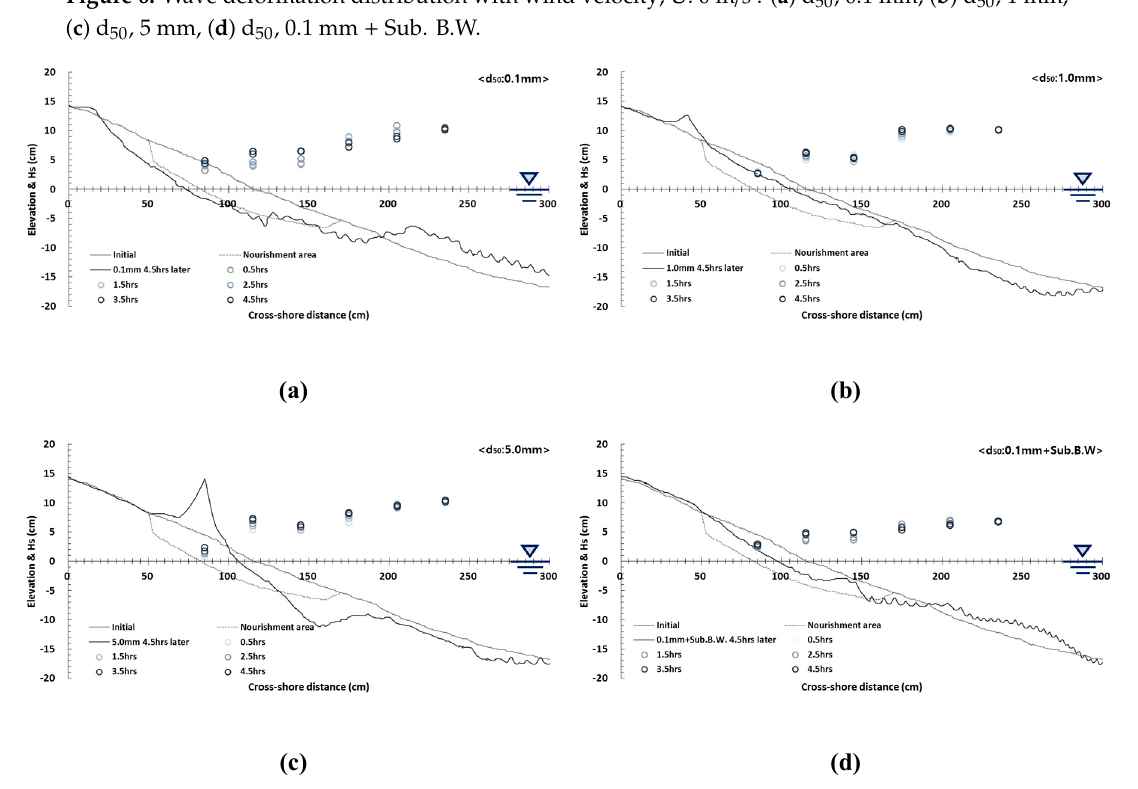
Figure 7. Wave deformation distribution with wind velocity; U: 8 m/s : ( a ) d 50 , 0.1mm, ( b ) d 50 , 1mm, ( c ) d 50 , 5mm, ( d ) d 50 , 0.1mm + Sub. B.W.